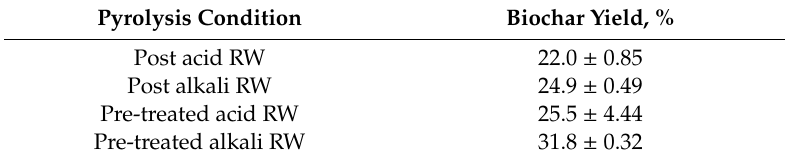
Table 4. Biochar yield for chemically treated rubber wood biochar, pyrolysed at 850 ◦ C.